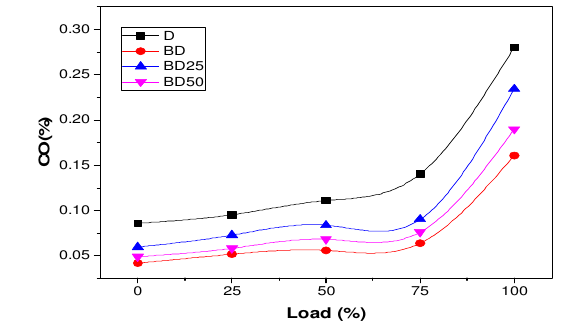
Fig. 6: Variation of engine load with CO emission with diesel and Jatropha-biodiesel